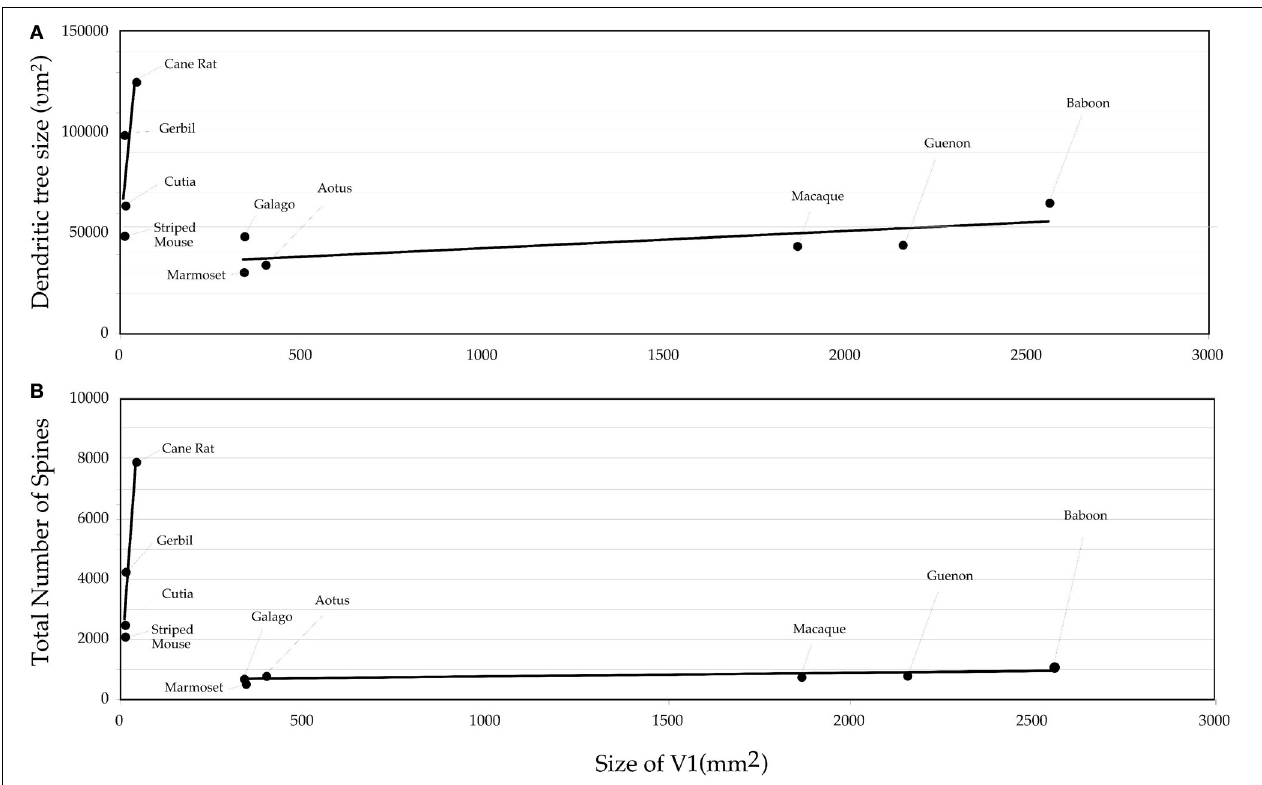
FIGURE 4 | Graph of the (A) size and (B) the number of dendritic spines in the “average” pyramidal cell vs. the size of the primary visual area (V1) in the cane rat, bushvelt gerbil, striped mouse, agouti, tree shrew,